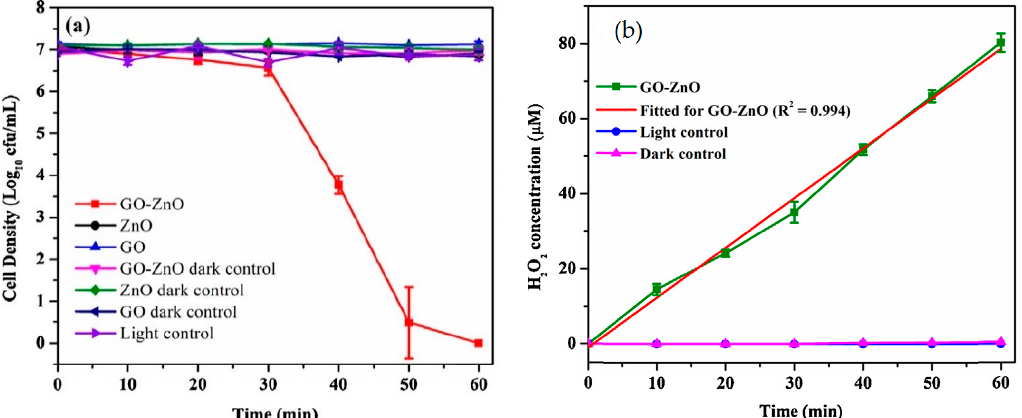
Figure 43. ( a ) Visible-light photocatalytic inactivation efficiency of E. coli (1 × 10 7 CFU/ mL) treated with GO/ZnO composite, GO and ZnO; ( b ) H 2 O 2 generation from GO/ZnO during the photocatalytic inactivation process under visible light. All the experiments and controls were conducted in triplicates. Reproduced from [173] with permisiion of Elsevier.